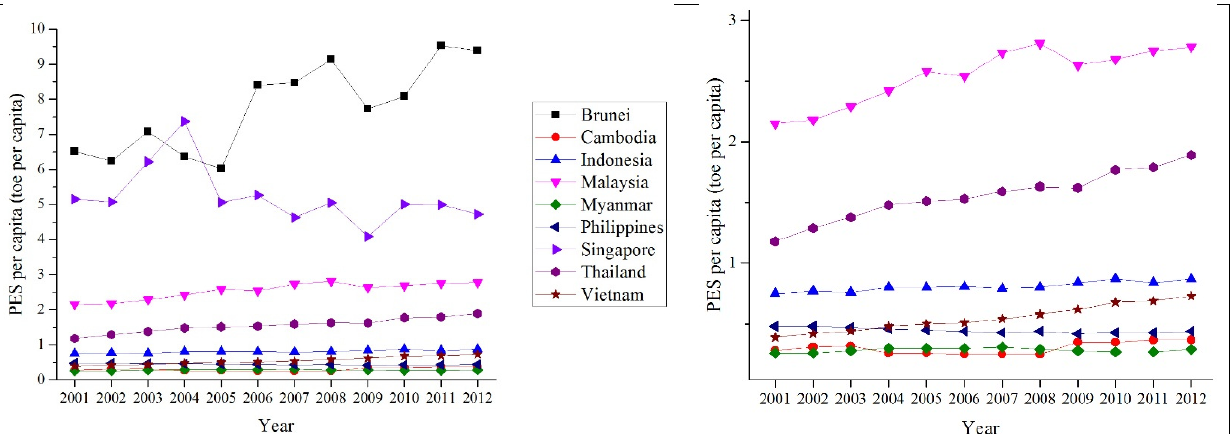
Figure 25. Primary energy supply per